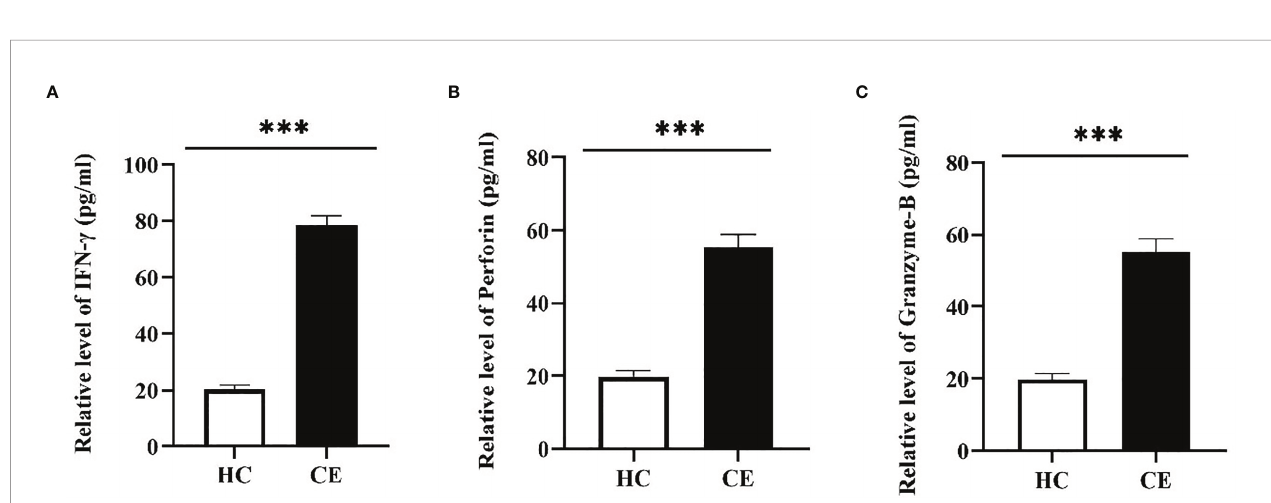
FIGURE 11 | The speci fi c cellular immunity tested by ELISA. The PBMCs of the HC group and the CE group were separated and co-cultured with the vaccine designed in this study. The CD4 + T-cell immune response was evaluated by detecting the secretion of IFN- g in the culture supernatant and the CD8 + T-cell immune response was evaluated by detecting the secretion of Perforin and Granzyme-B. (A) The relative level of IFN- g in the HC group and the CE group. (B) The relative level of Perforin in the HC group and the CE group. (C) The relative level of Granzyme-B in the HC group and the CE group. The relative level of CE group was higher than that of HC group. (*** P <